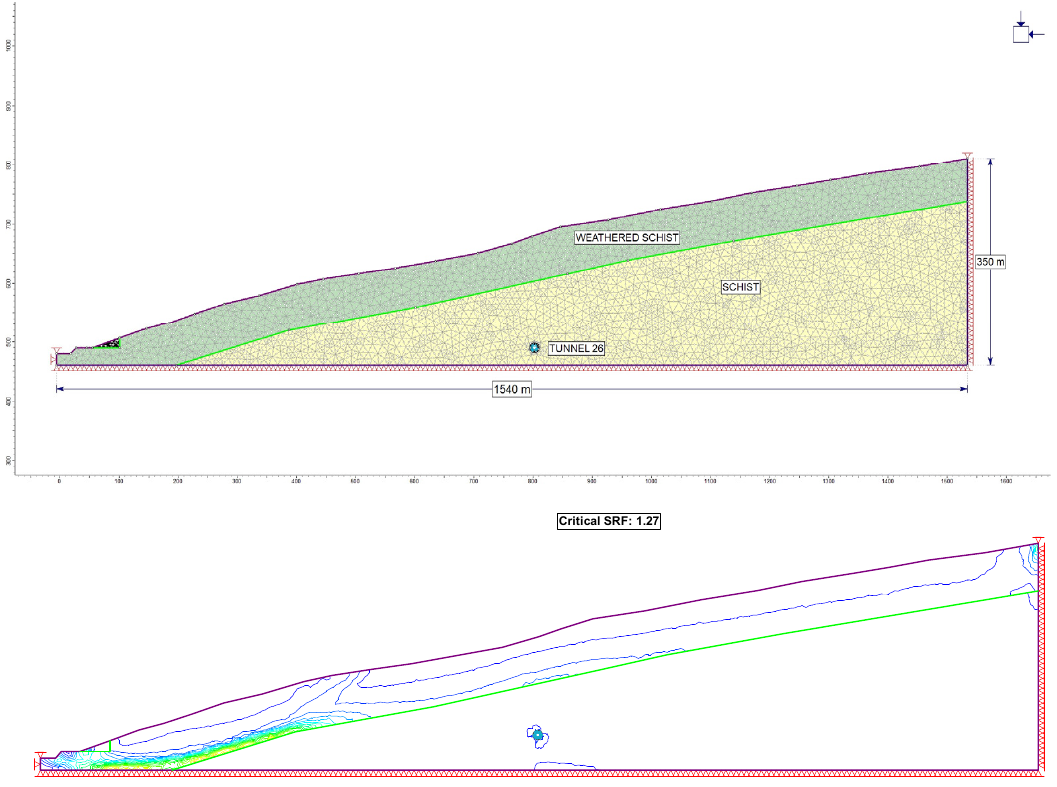
Figure 19. Phase2D model for the slope stability analysis (SRF analysis) and the result of slope stability analysis.